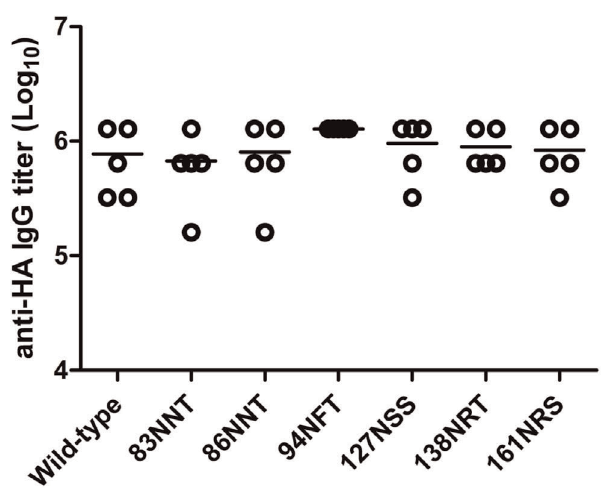
Figure 7. Total anti-HA IgG titers elicited by hyperglycosylated DNA vaccine priming followed by FliC-VLP boosting. Mice were immunized with each immunorefocusing HA vector twice followed with a third boosting dose with FliC-VLPs on a three-week interval. Sera were collected at 2 weeks after final immunization, and determined the anti- HA IgG titers by ELISA. The results showed that no significant differences of the HA-specific total IgG titers of all the immunized groups with the hyperglycosyalted HA DNA vaccines compared to the wild-type control. Individual titers (points) and geometric means (lines) are given for each